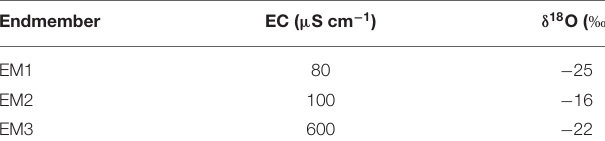
TABLE 2 | Electrical conductivity (EC) and δ 18 O for water source endmember.